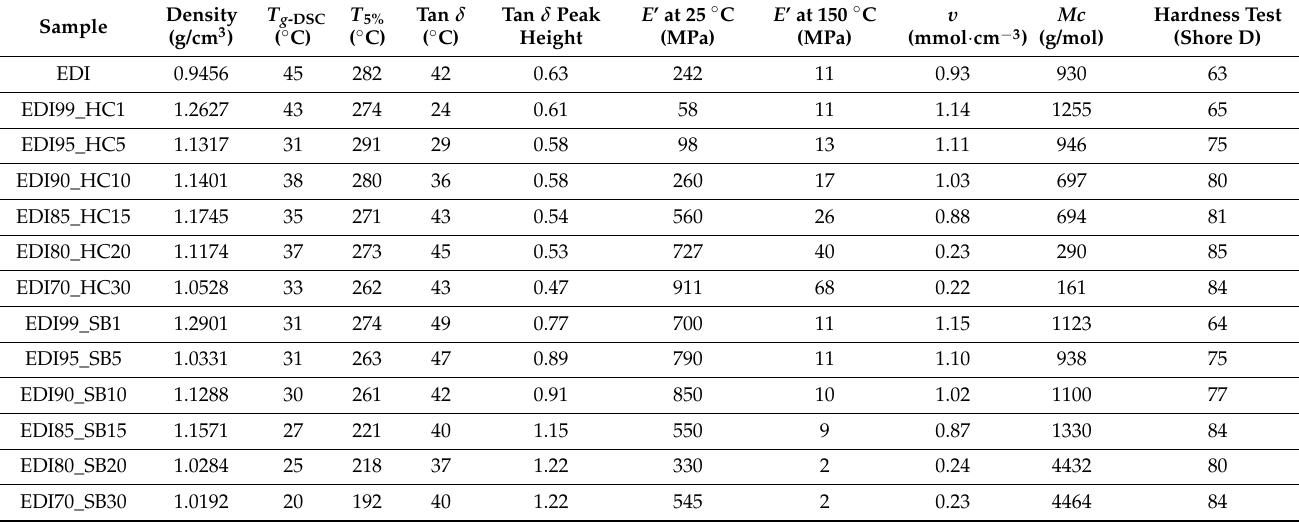
Table 2. Physico-chemical and thermo-mechanical properties of the